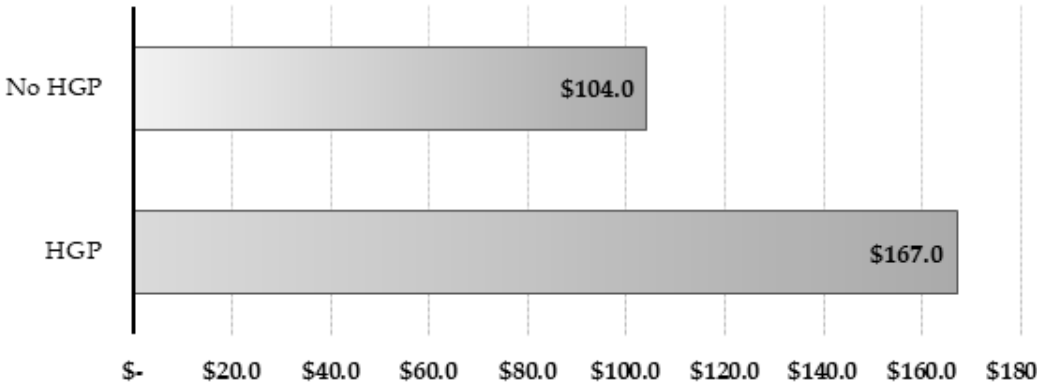
Figure 4. Marginal income (US $) per steer obtained due to the use of growth promoting implants (Implant cost + Labor = US $3.2 per animal. Sale price US $1.7 per kg of BW (Auction Osorno FEGOSA; HGP = hormonal growth promoting)).